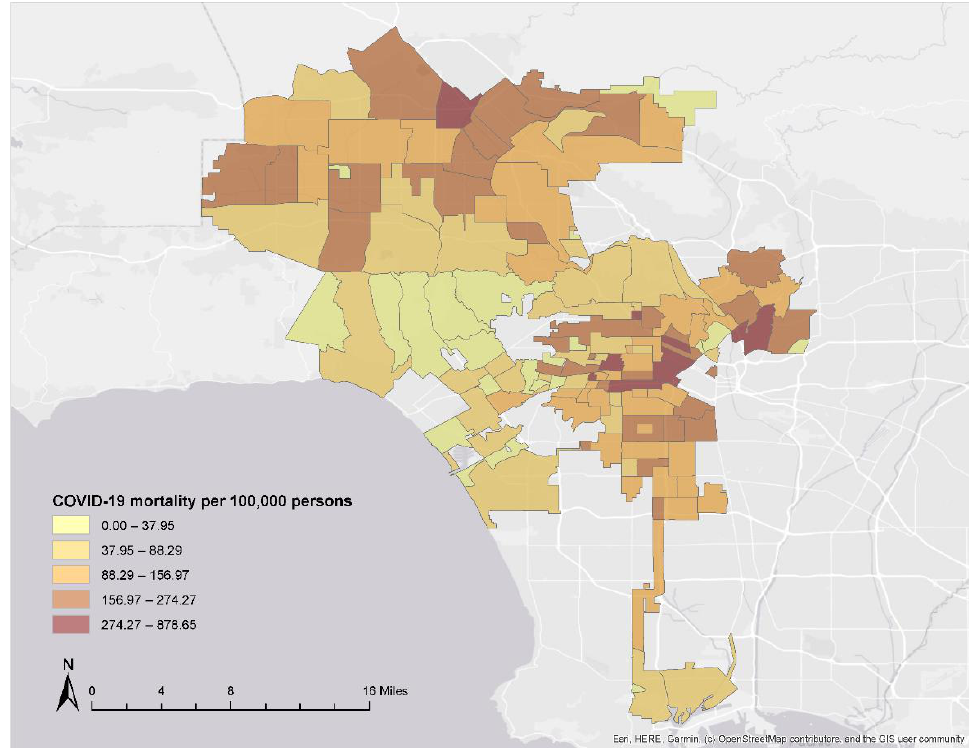
Figure 2 . Los Angeles City/Community COVID-19 Mortality Rates . Figure 2. Los Angeles City/Community COVID-19 Mortality